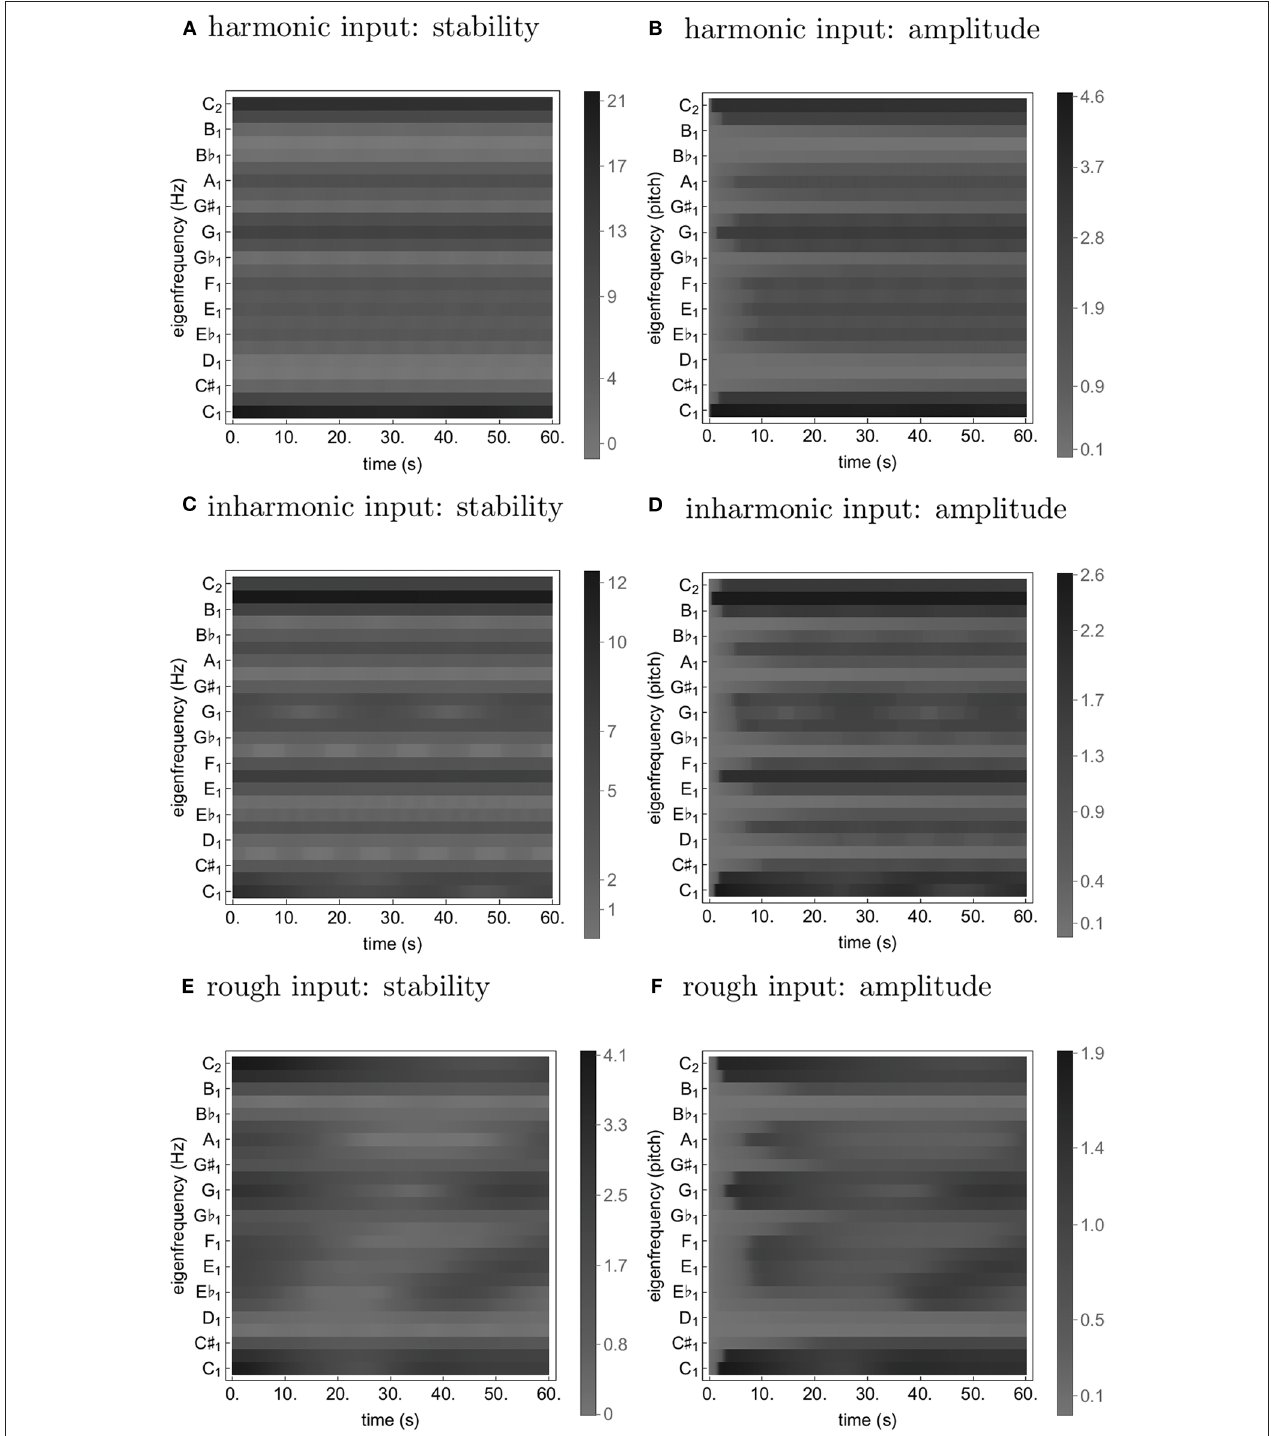
FIGURE 2 | Time traces from simulations of Equation (24) with a loud harmonic (A,B) , inharmonic (C,D) , and rough (E,F) input. The stability (A,C,E) is quantified as ( J ) [0,0] (see Equation 2); the amplitude (B,D,F) is simply ℜ (cid:0) (cid:1)